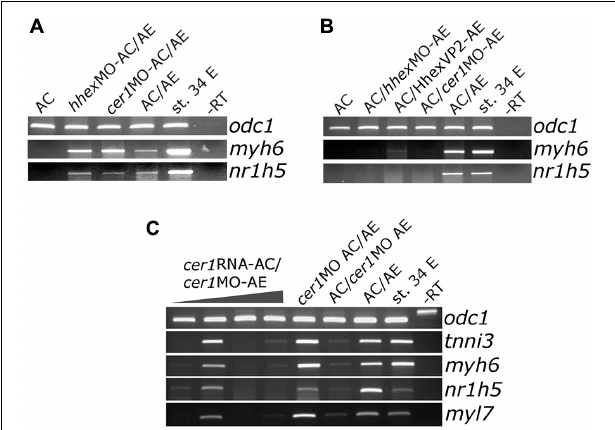
FIGURE 3 | Cerberus and hhex are required in anterior endoderm for liver and cardiac specification. (A) Injection of cer1 or hhex MOs (10 or 20 ng/embryo, respectively) in AC have no effect on heart and liver marker expression in AC/AE conjugates. This is in contrast to (B) , where injection of cer1 or hhex MOs in AE leads to downregulation of both cardiac and liver marker gene mRNA levels in conjugates. Injection of mRNA (500 pg/embryo) coding for dominant negative Hhex-VP2 construct had the same effect as hhex MO. (C) Cardiac and liver specification deficiency in AC/ cer1 MO-AE conjugates can be rescued by Cerberus. c er1 mRNA was injected in AC at increasing concentrations, from left to right; 100, 200, 500, and 1000 pg per embryo. All samples were cultured until stage control had reached stage 34 where PCR was carried out for indicated markers.